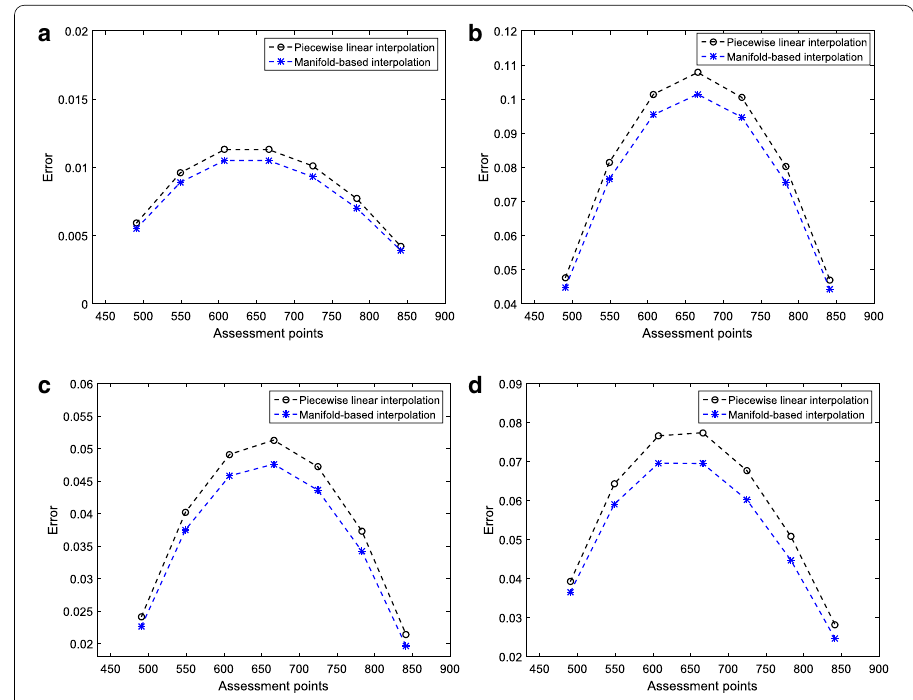
Fig. 4 Interpolation error for some assessment points in the parameter space (traditional piecewise linear interpolation vs proposed manifold-based interpolation). a Error of temperature field. b Error of displacemen field. c Error of stress field. d Error of plastic strain field